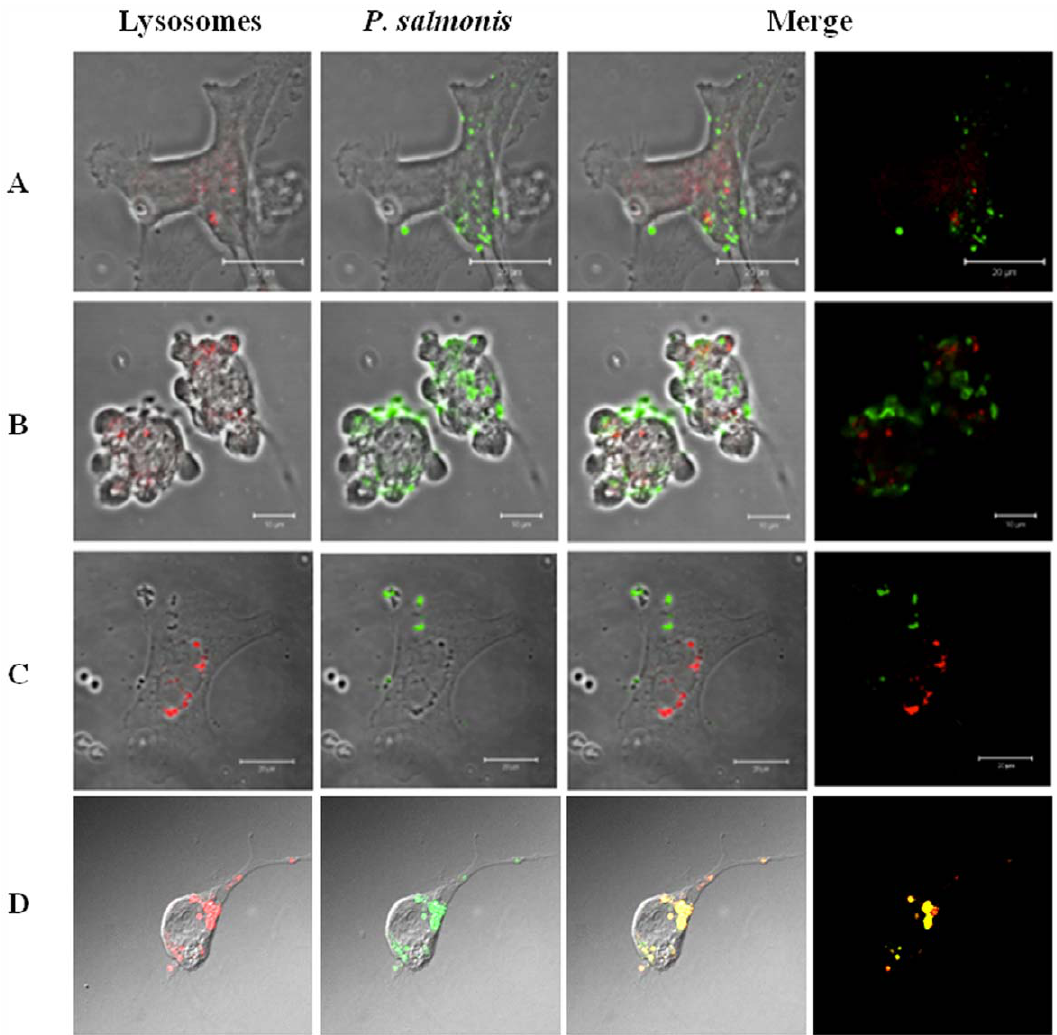
Figure 4. Confocal Laser Scanning Microscopy of P.salmonis infection on three cell lines showing the escape of phagosome- lysosome fusion. The immunofluorescence was made 5 days post-infection. Lysosomes were stained in red with LysoTracker Red reagent and P. salmonis was detected with a FITC conjugated antibody. A: CHSE-214 cell line infected with P. salmonis . B: Sf21 cell line infected with P. salmonis . C: RTS11 cell line infected with P. salmonis . D: CHSE-214 cell line infected with formaldehyde-inactivated P. salmonis , the immunofluorescence stain was made at 48 hours after infection.